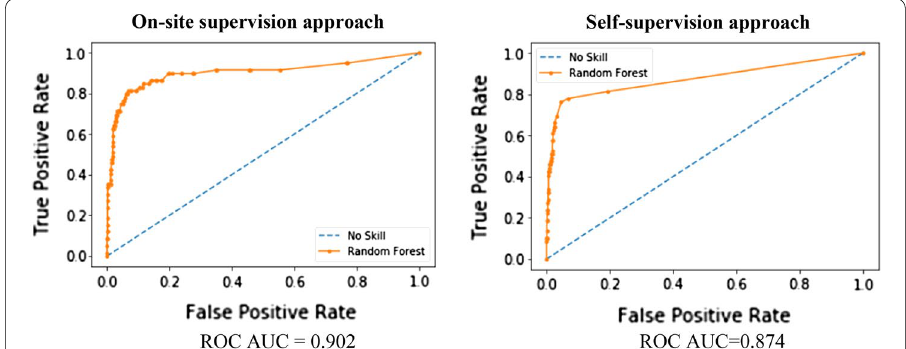
Fig. 5 ROC curves and AUC measure for both supervisory